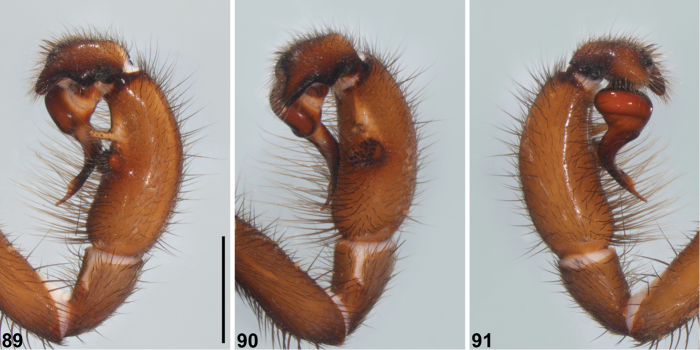

Idiosoma
clypeatum sp. n., male holotype (WAM T96452) from Albion Downs (Western Australia; MUR), pedipalp. 89 Retrolateral view 90 Retroventral view 91 Prolateral view. Scale bar 2.0.